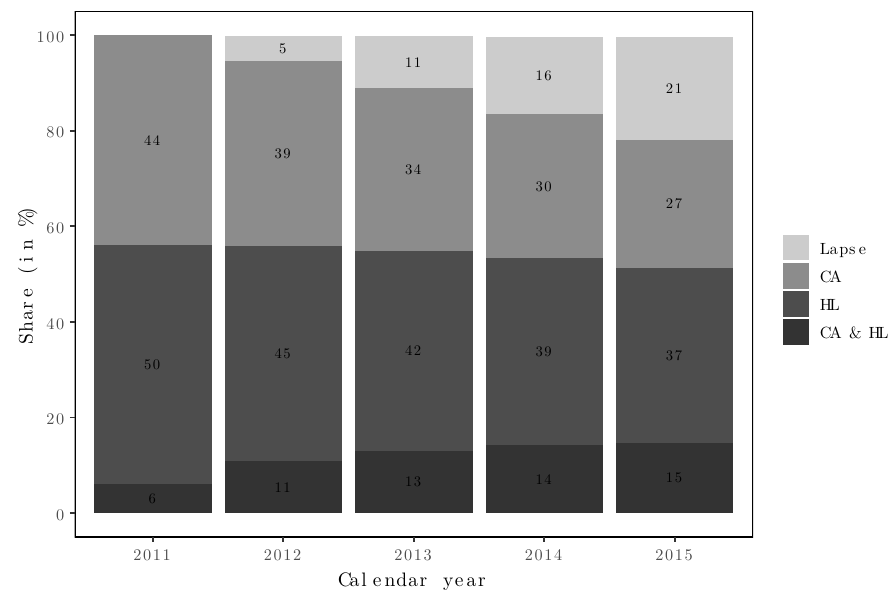
Figure 2. Illustration of the portfolio